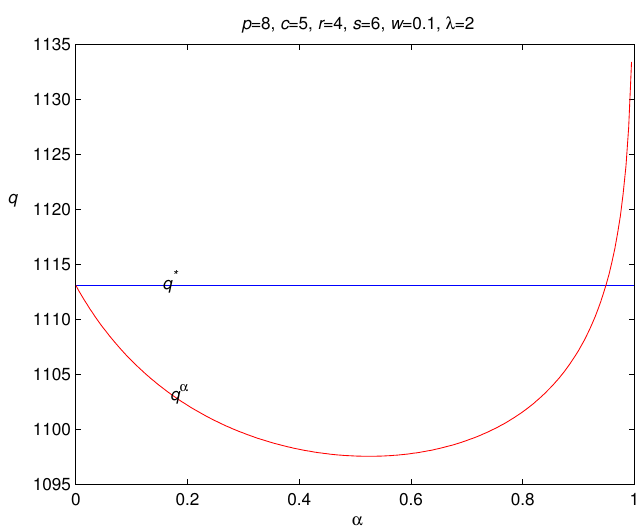
Figure 5. Optimal order quantities q ∗ and q α with different confidence level α